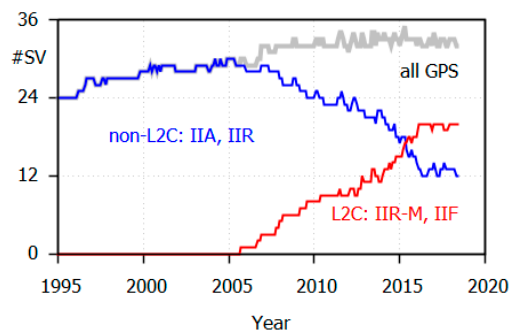
Figure 1. Development of the global positioning system (GPS) space segment with respect to L2C capable satellites (data source: IGS file of antenna corrections IGS14_2000.ATX).